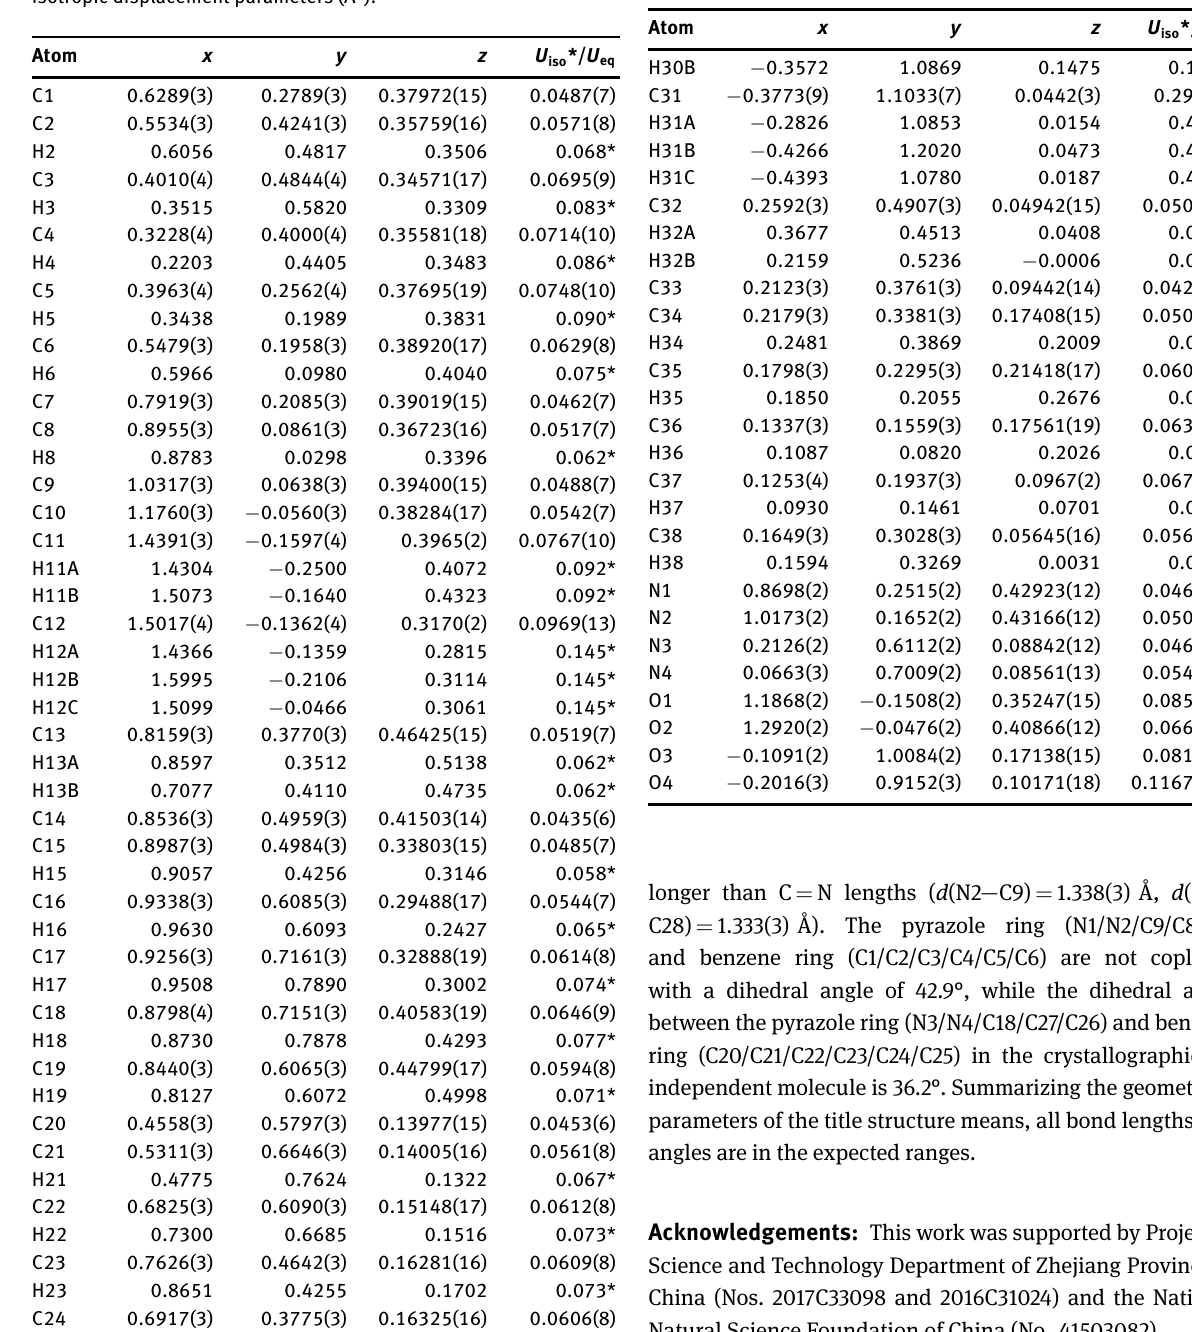
Table 2: Fractional atomic coordinates and isotropic or equivalent isotropic displacement parameters (Å 2